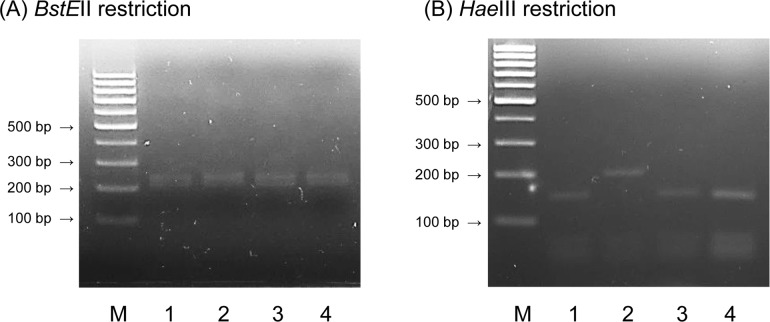
Differentiation of two Rec-mas-H strains by PCR-restriction enzyme and polymorphism analysis (PRA) of hsp65.Amplified hsp65 gene amplicons were digested with (A) BstEII and (B) HaeIII restriction enzymes. M, 100-bp DNA ladder; Lane 1, M. abscessus subsp. abscessus CIP 104536T; Lane 2, M. abscessus subsp. massiliense CIP 108297T; Lane 3, Asan 55814; Lane 4, Asan 55262.